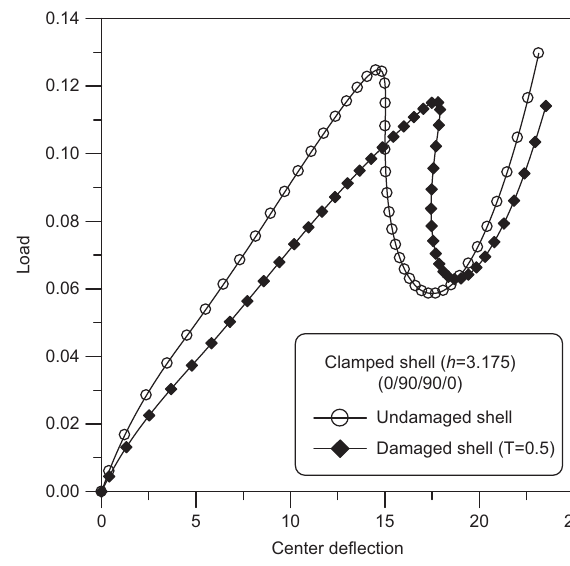
Figure 12 Load-displacement curves of clamped cylindrical